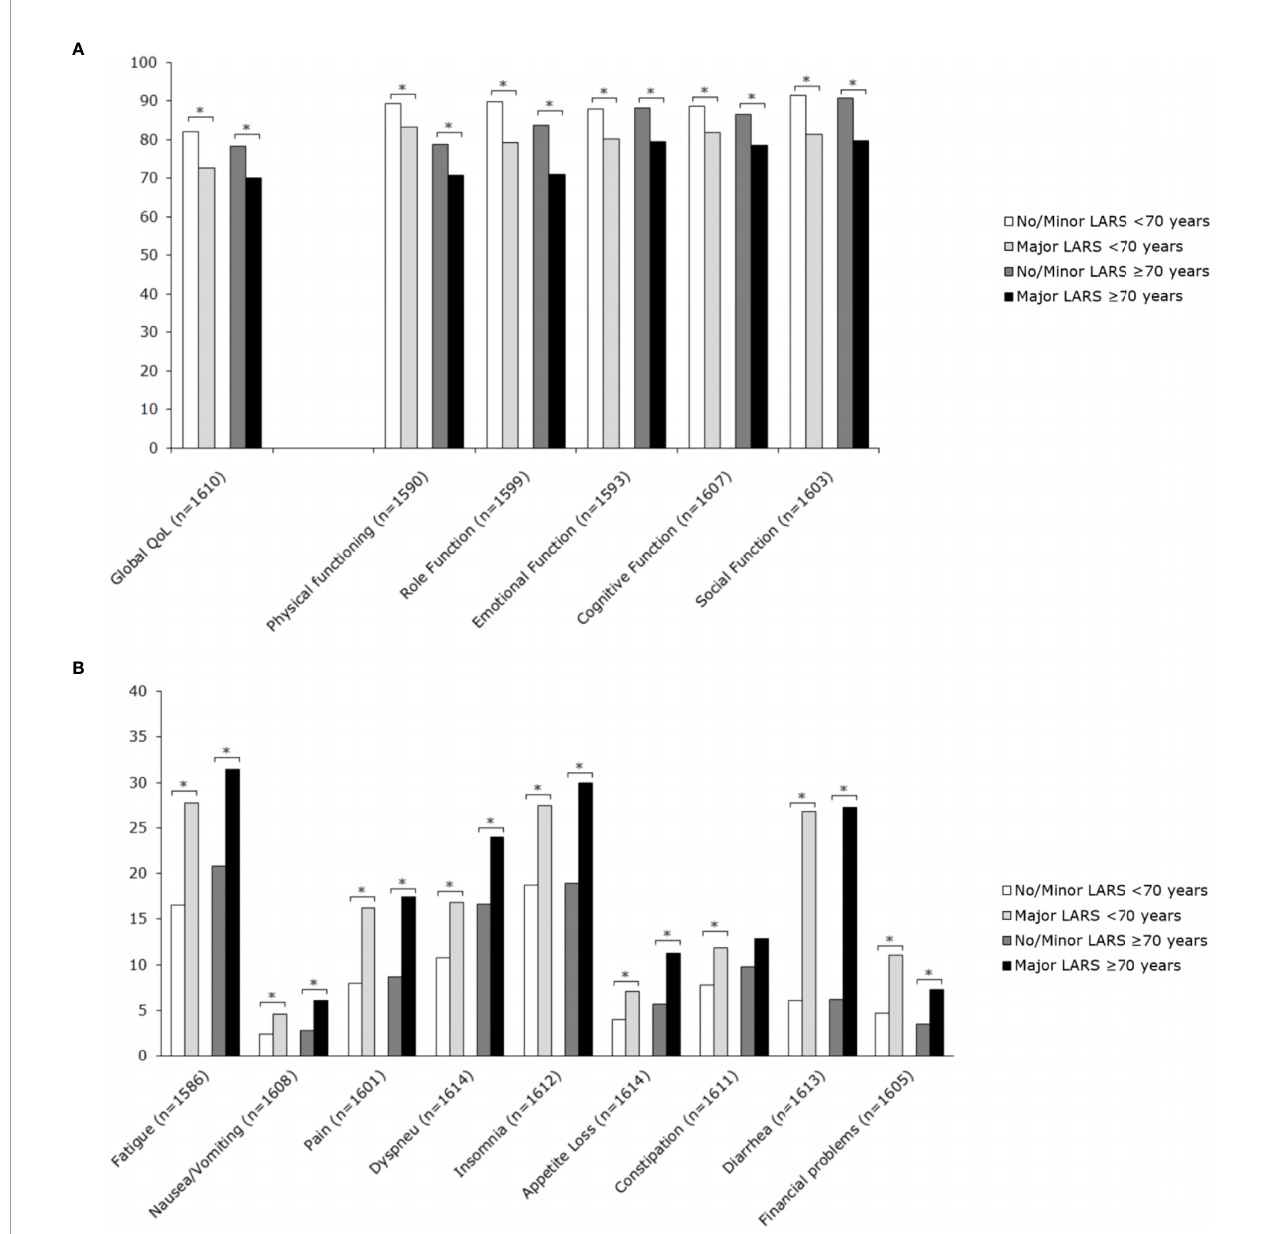
FIGURE 3 | Mean scores of EORTC QLQ-C30 subscales for patients <70 years and ≥ 70 years, strati fi ed by LARS group. (A) Functional scales: A higher score represents a better level of functioning. (B) Symptom scales: A higher score represents a higher level of symptoms. Signi fi cant differences are indicated by an asterisk; p -value <